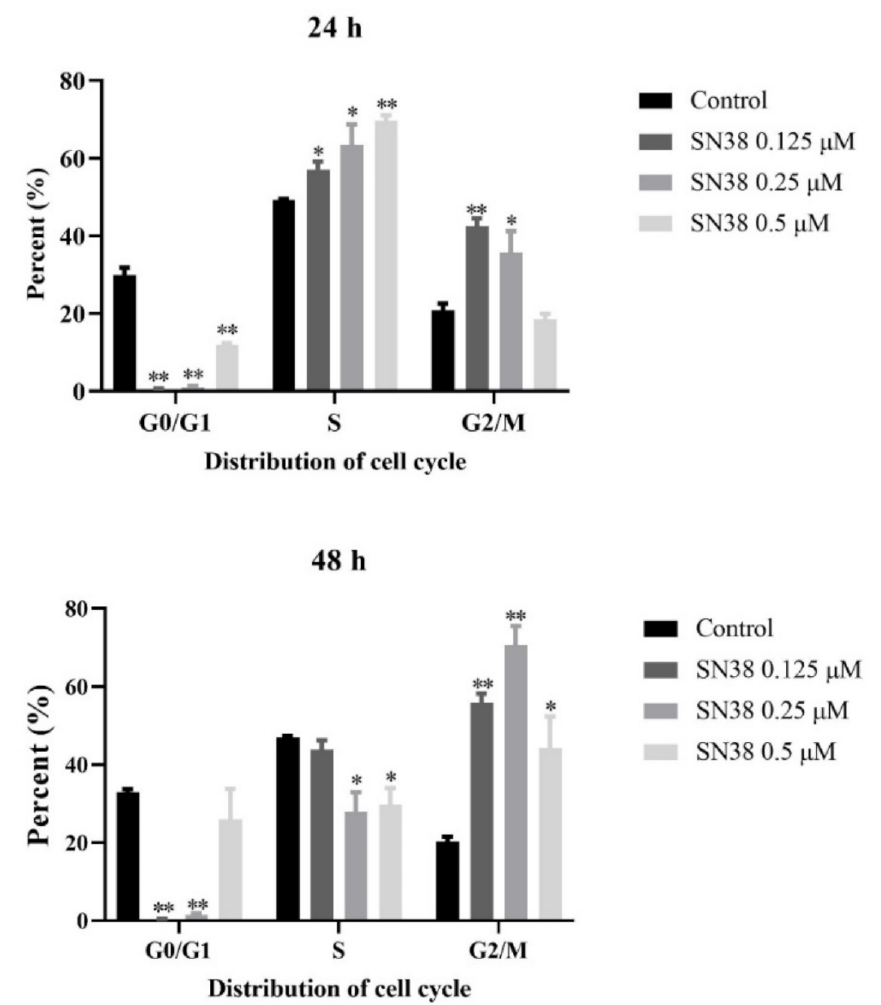
Figure 2. Effect of SN38 on cell cycle in HCT 116 cells for 24 and 48 h. Note: * p < 0.05, ** p < 0.01, compared with control